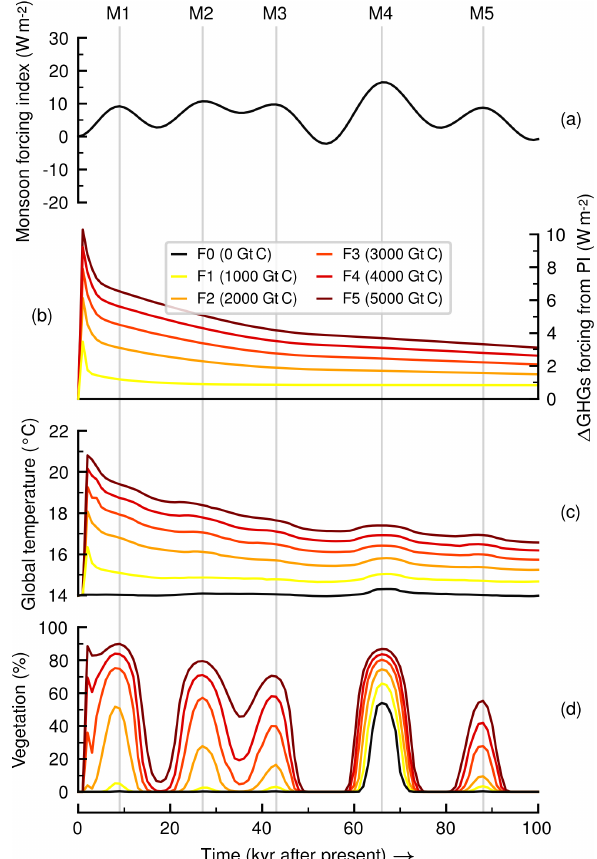
Figure 6. AHPs in future climate change scenarios for the next 100kyr: (a) computed monsoon forcing index, (b) scenarios of GHG radiative forcing changes from PI era, (c) simulated global near-surface temperature and (d) modelled vegetation fraction in the Sahara grid box. Vertical lines indicate future peaks in the mon- soon forcing index. Total cumulative emissions of carbon are shown in parentheses in the